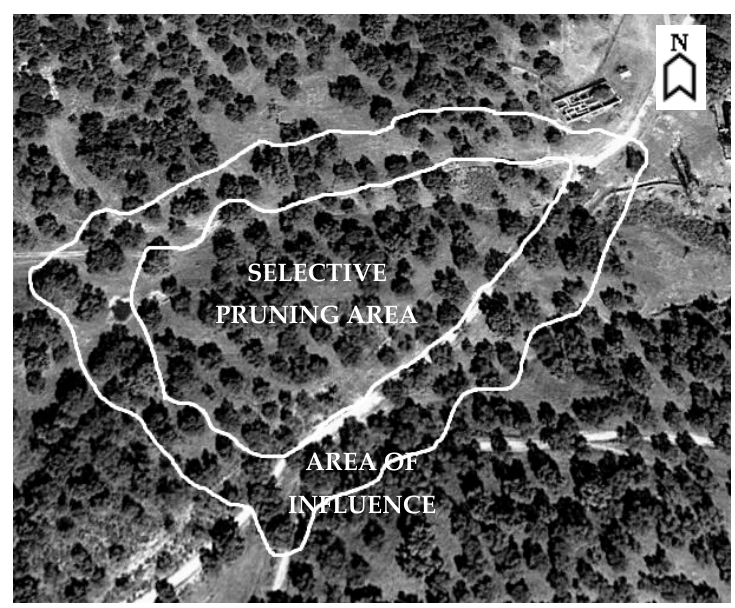
Figure 3. Orthophoto showing one of the Selective Pruning Areas and its Area of Influence.